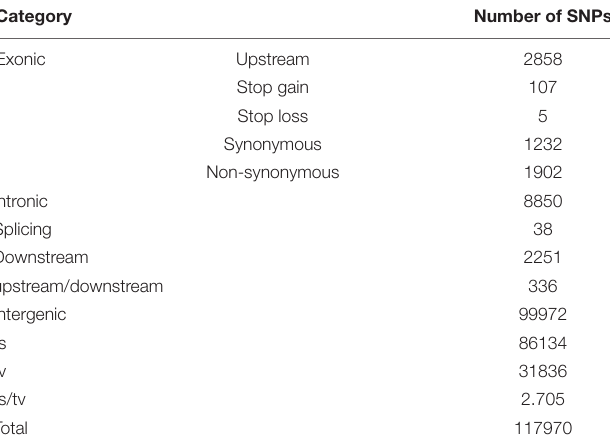
TABLE 2 | SNPs distribution in G. uralensis